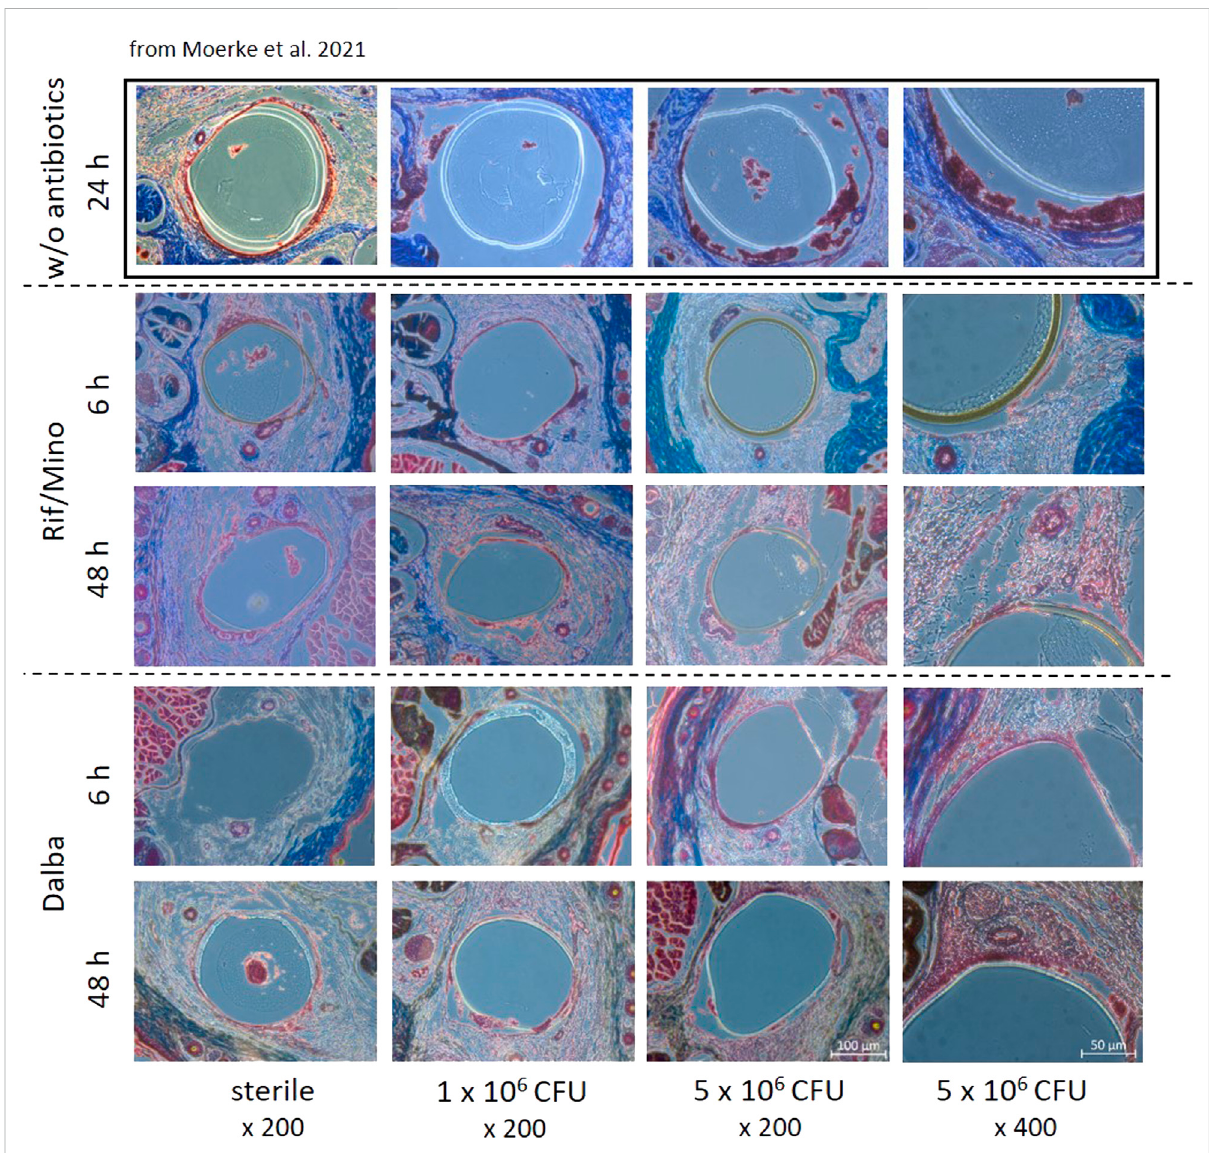
FIGURE 6 Histological trichrome staining oftail cross sectionswas performed after 6 and 48 h. Representativeimages ofmice tails that received implants without antibiotic coating (excerpted from Moerke etal. (Moerke etal., 2021)), coatedwith rifampicin/minocycline,and dalbavancin are shown;